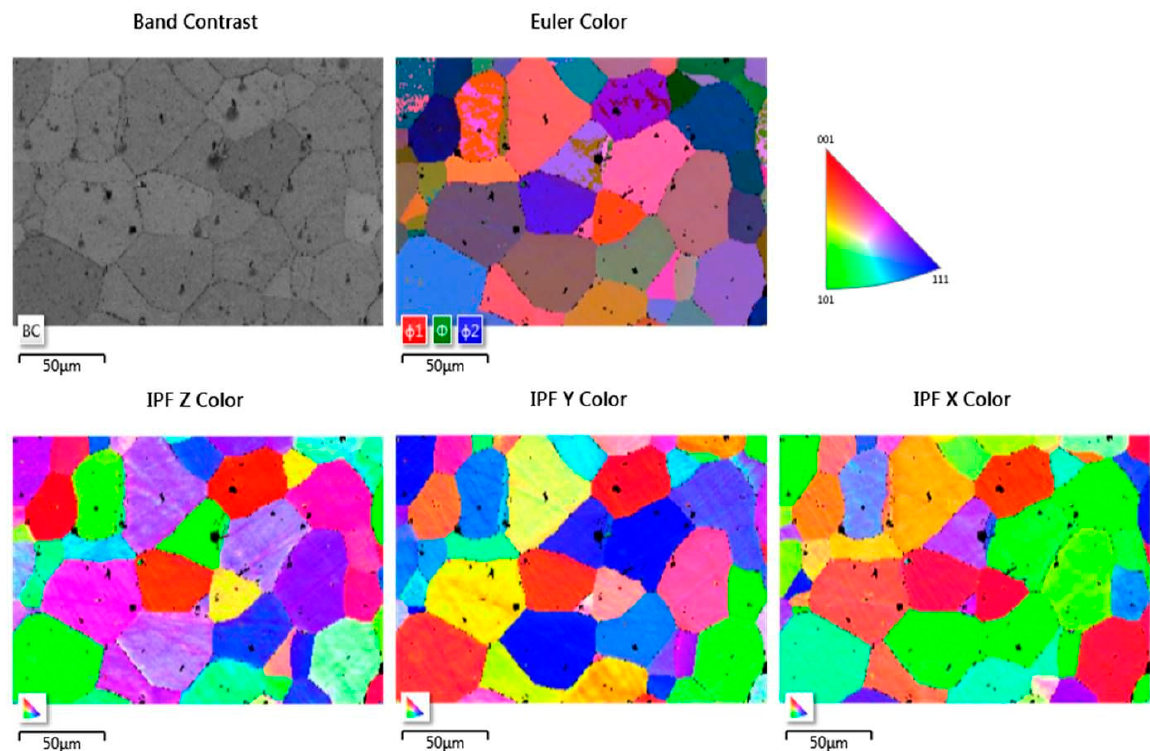
Figure 7. EBSD images of sputtered area of steel 1.4521 (AISI 444).